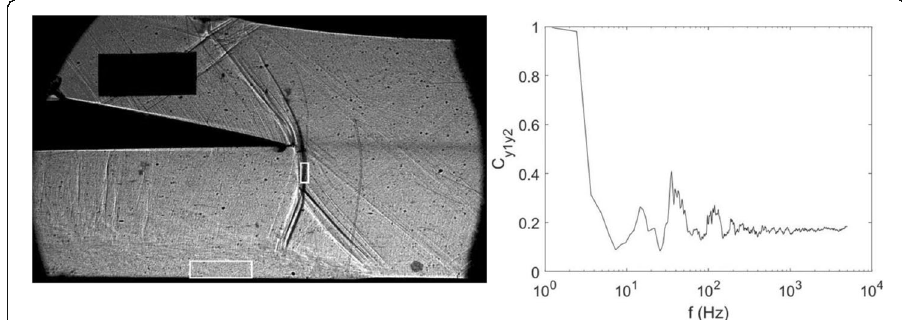
Fig. 3 a Instantaneous shadowgraph image showing shock wave characteristics. Rectangles mark the locations of the pixels in the downstream boundary layer and on the shock wave associated with magnitude squared coherence determination. b Magnitude squared coherence variation with frequency of data associated with locations near the shock wave and in the downstream boundary